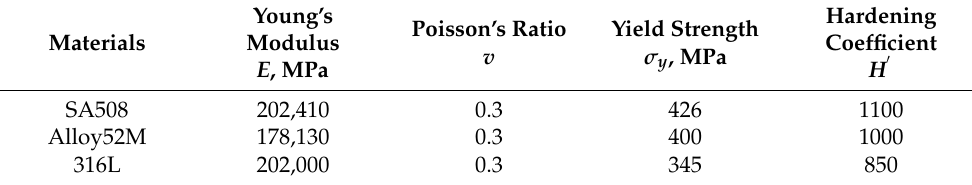
Figure 2. Physical diagram of dissimilar metal welded joints and sampling area.